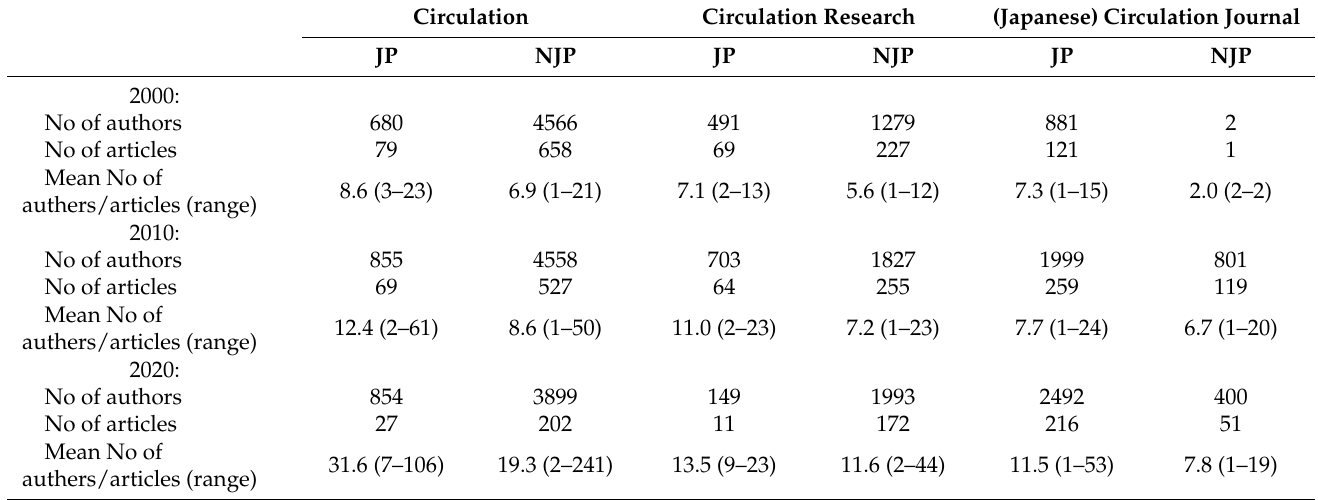
Table 1. Comparison of number of authors per article by Japanese (JP) and non-Japanese (NJP) categories.